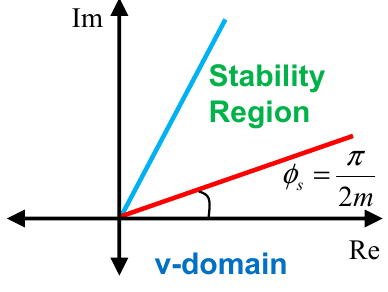
m vs = mapping [11,14,17]. Figure 1. The stability regions under s = v m mapping [11,14,17].